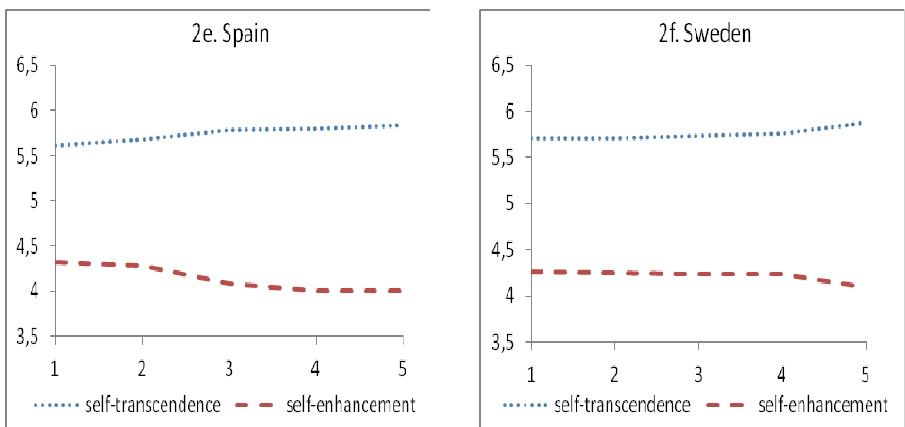
Figure 3: Public opinion net self-transcendence score for selected countries